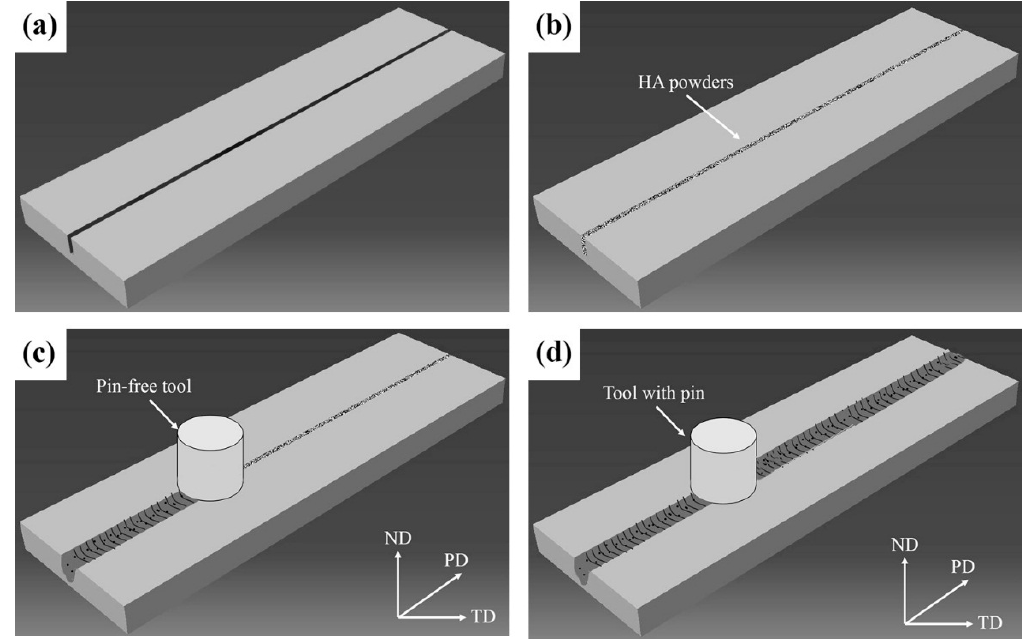
Figure 2. Schematic illustration of the processing